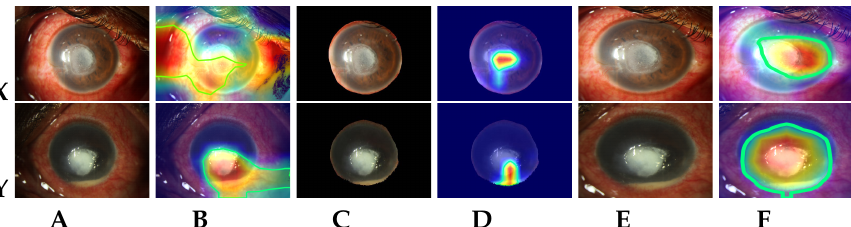
Figure 5. Confusion matrix obtained with ten-fold CV using our model.